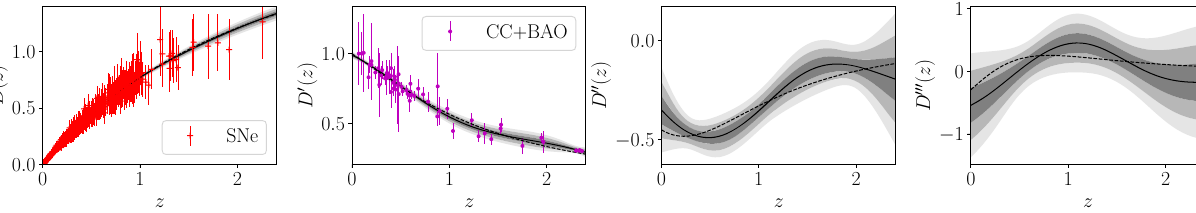
0 . 2 z Fig. 7 Plots for the reconstructed dimensionless co-moving luminosity distance D ( z ) , it’s derivatives D (cid:3) ( z ) , D (cid:3)(cid:3) ( z ) and D (cid:3)(cid:3)(cid:3) ( z ) using combined Pantheon + CC data. The black solid line is the best fit curve. The associated 1 σ , 2 σ and 3 σ confidence regions are shown in grey. The specific points (in the top two figures) with error bars represent the observational data. The black dashed line is for the (cid:2) CDM model: (cid:12) m 0 = 0 . 3